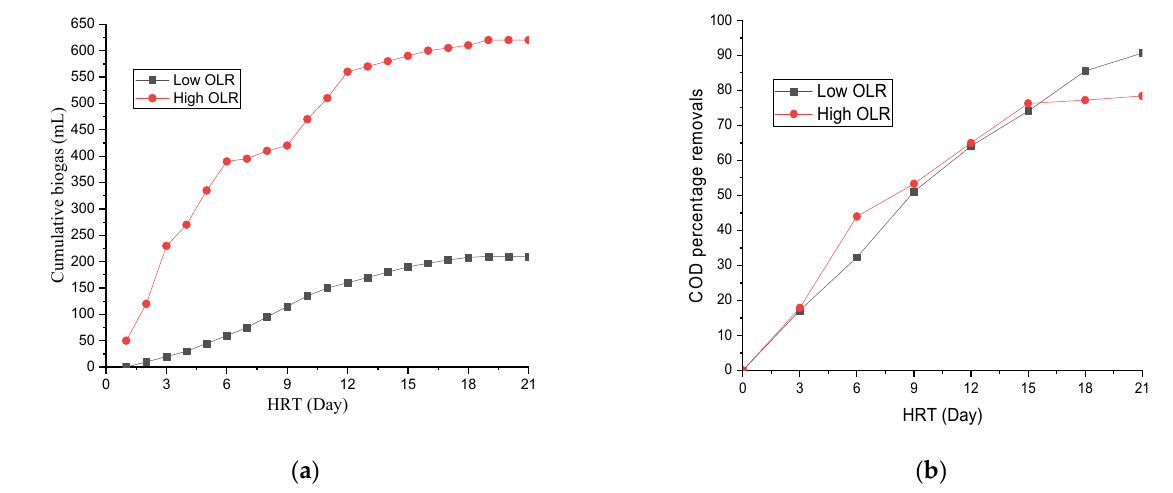
Figure 7. The e ff ect of organic loading rate on ( a ) cumulative biogas production; ( b ) degradation of chemical oxygen demand (COD).